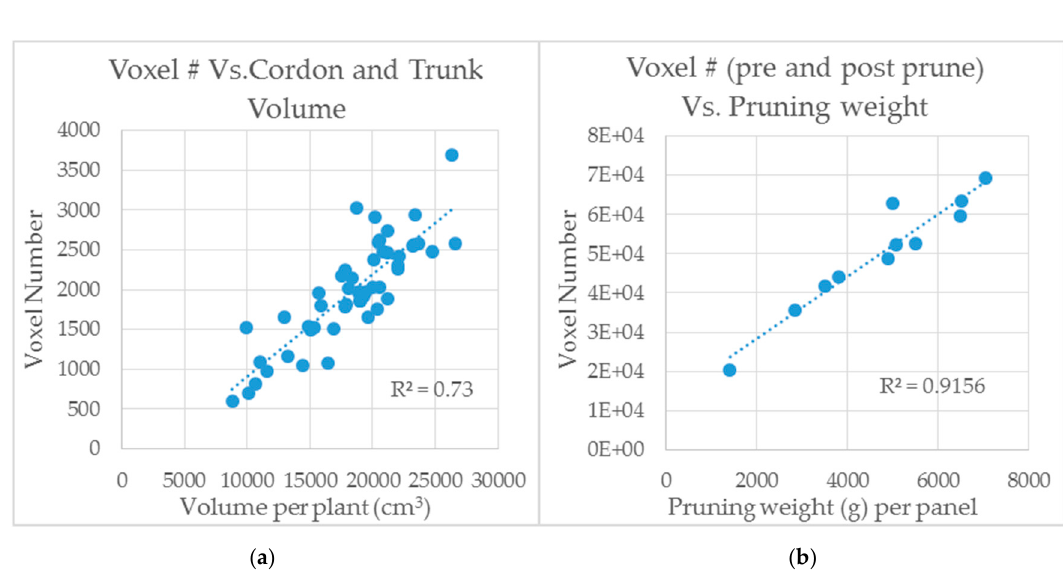
Figure 5. This shows the relationship between LMS-400 scans vs. trunk and cordon volume ( a ) and pruning weight ( b ). Measurements were made at the South Australian Research and Development Institute (SARDI) Research Facility, Nuriootpa, South Australia. A different planting of the Shiraz variety at the SARDI site was used for trunk and cordon volume measurements relative to that used for pruning weight measurements.